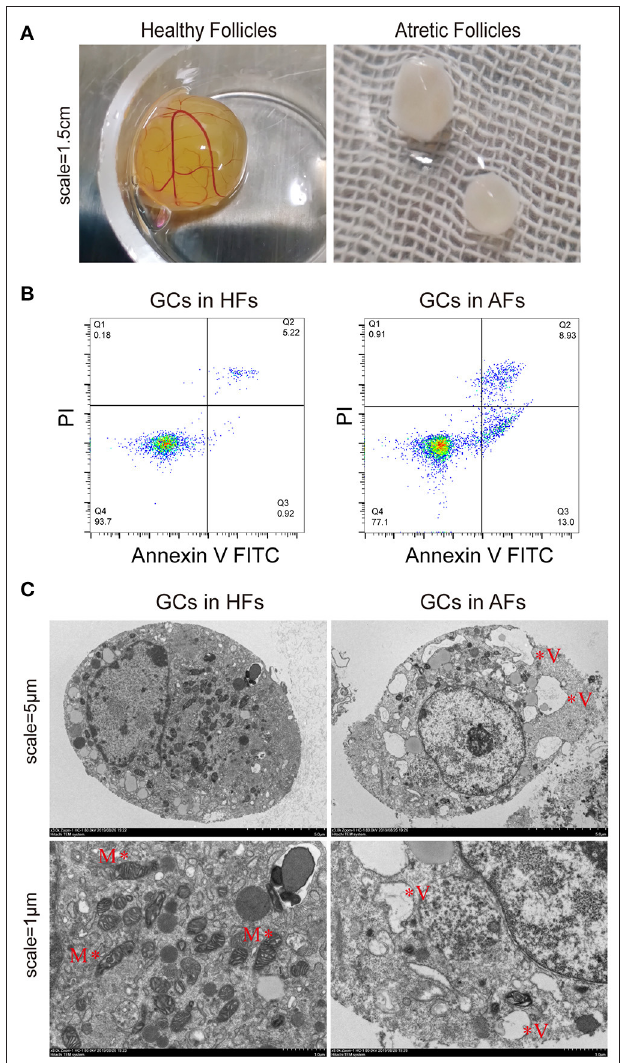
FIGURE 1 | Phenotypic detection of healthy and atretic follicles. (A) The appearance of follicles with scale bars = 1.5 cm: the capillaries were rich on the surface of healthy follicles, and the follicular fluid was yellow, while little or no capillaries were seen on the surface of atretic follicles, and the follicular fluid was grayish white. (B) The apoptosis rate of the granulosa cells ( n = 3) of healthy and atretic follicles was assessed by flow cytometry. (C) Transmission electron microscope of granulosa cells in healthy and atretic follicles with scale bars = 5 and 1 µ m, respectively. M indicates mitochondria, and V represents vacuoles.